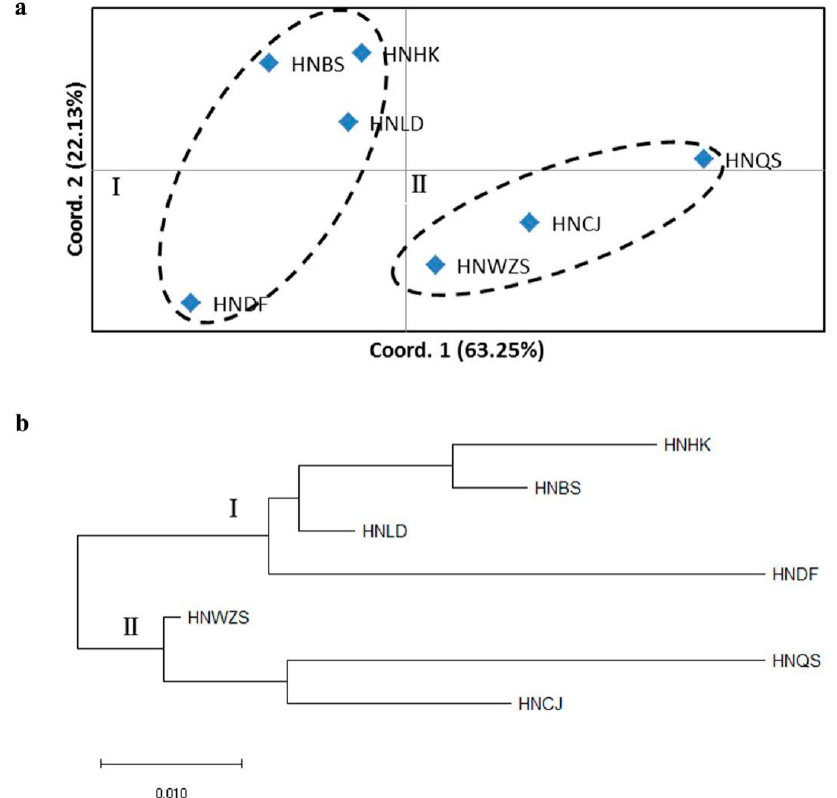
with cluster number (K) ranged from one to seven. ( c ) Estimated genetic structure of the seven populations based on STRUCTURE analysis with cluster number (K) of two. In each plot, different color represents a different cluster and black segments separate the populations.